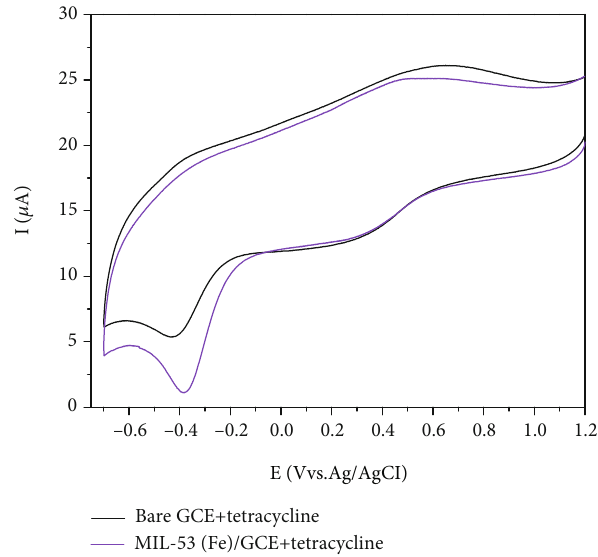
Figure 3: CVs of bare GCE and MIL-53 (Fe)/GCE in 1 M H with 1.278 μ mol/L tetracycline,